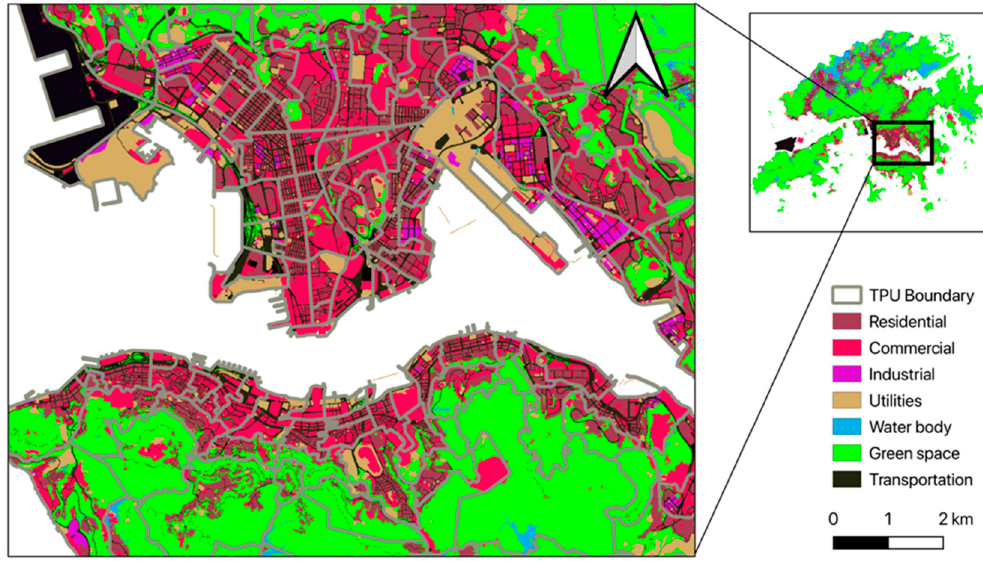
Figure 2. Land-use Figure 2. Land-use dataset.